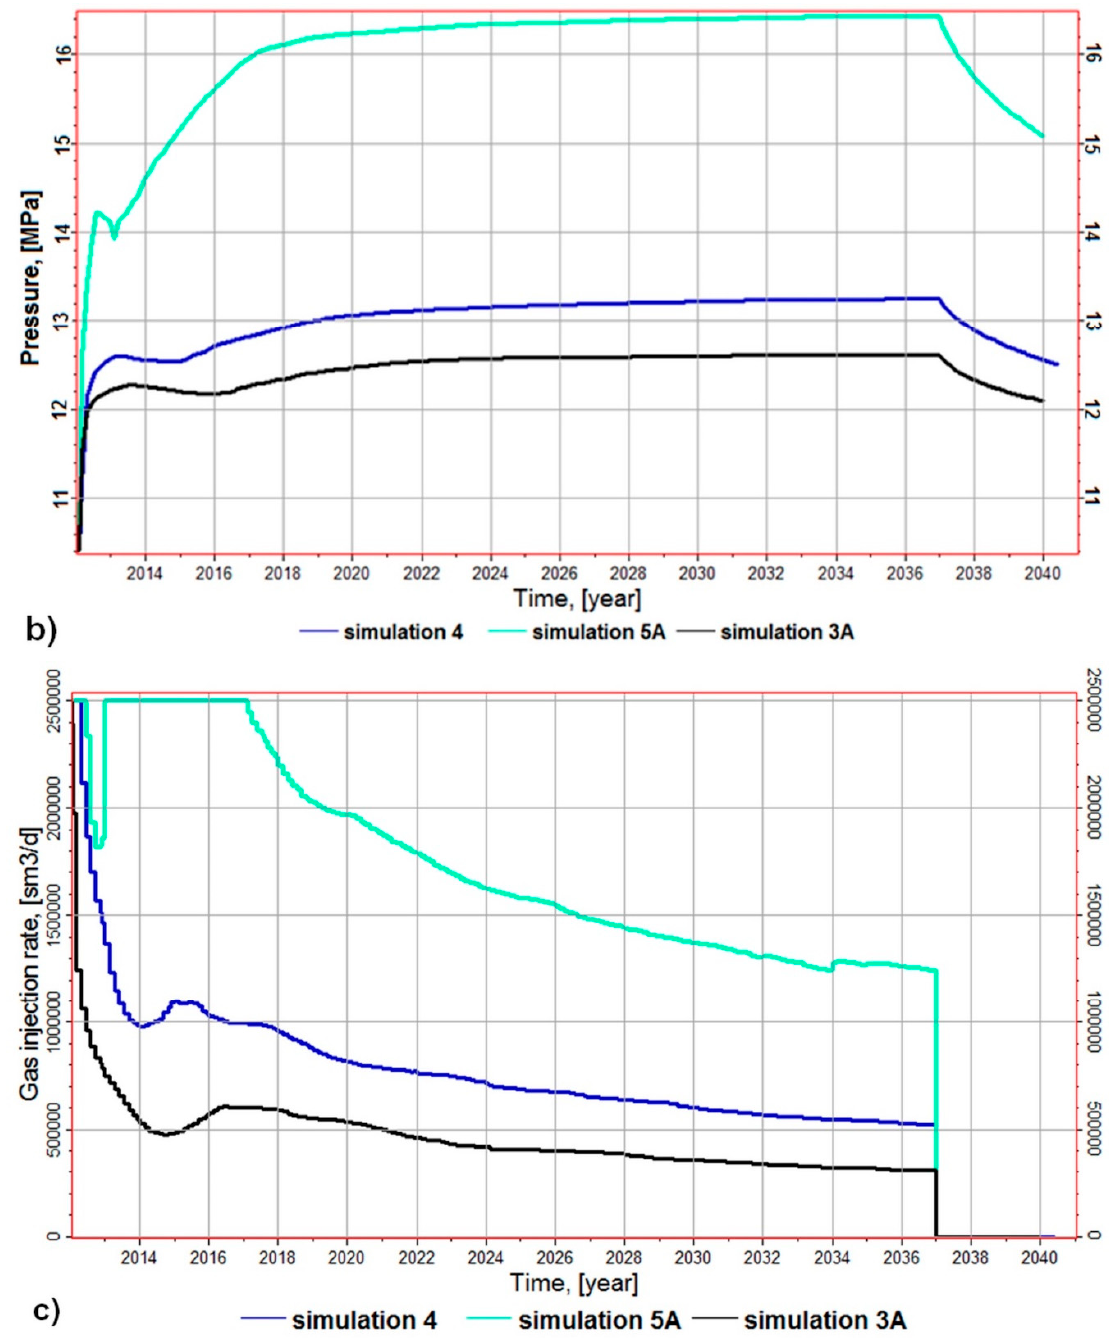
Figure 16. Comparison of changes in the amount of free CO 2 over time in the structure ( a ), changes in the average pressure over time in the injection zone ( b ) and changes in the injection efficiency ( c ) for three simulation variants: S3A, S4, and S5A.